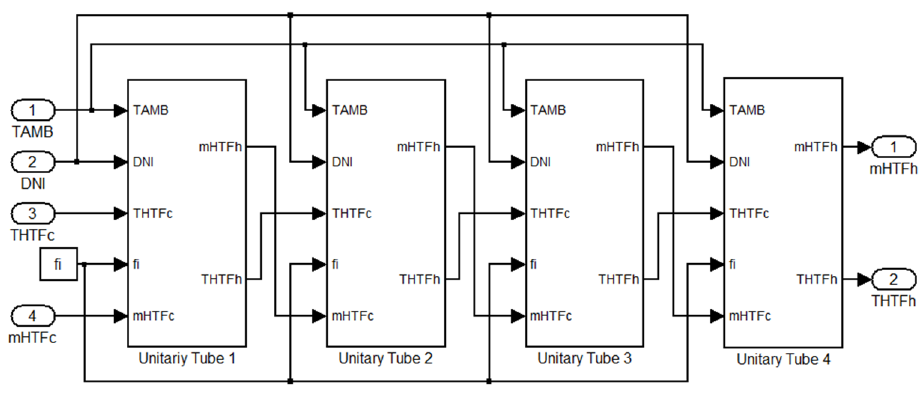
Figure 10. Loops model.